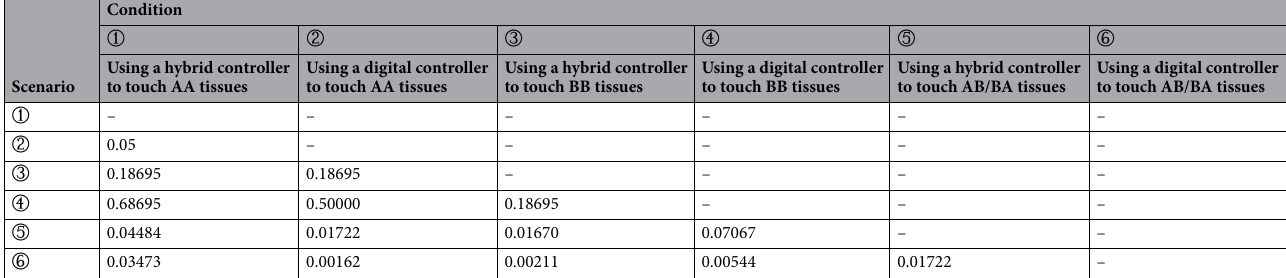
Table 1. Right-tailed T-test results under different control